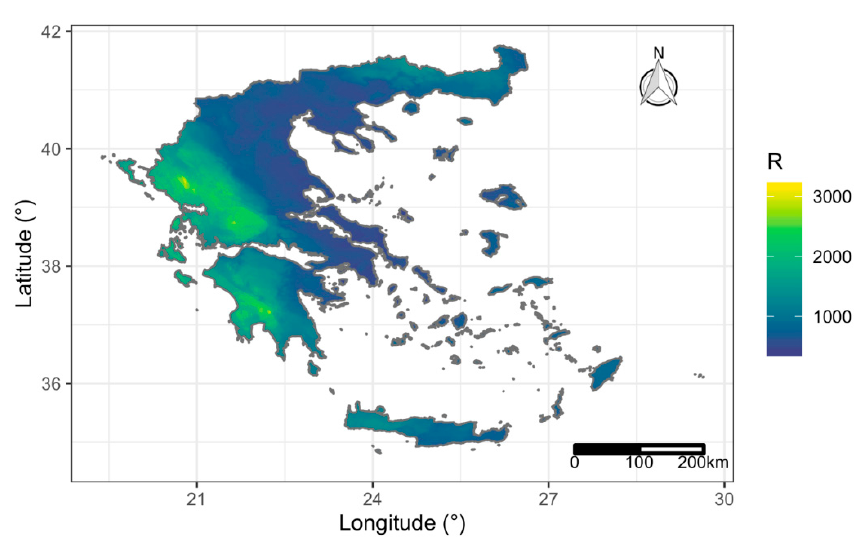
Figure 5. Monthly erosivity estimation. Units are in MJ·mm/ha/h/month.